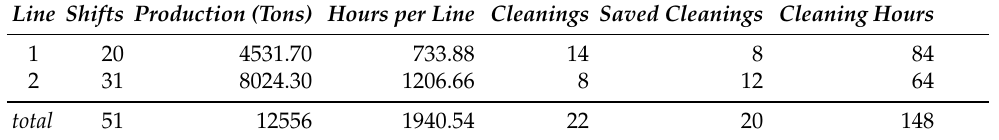
Table 4. Production and cleanings for the considered case study.